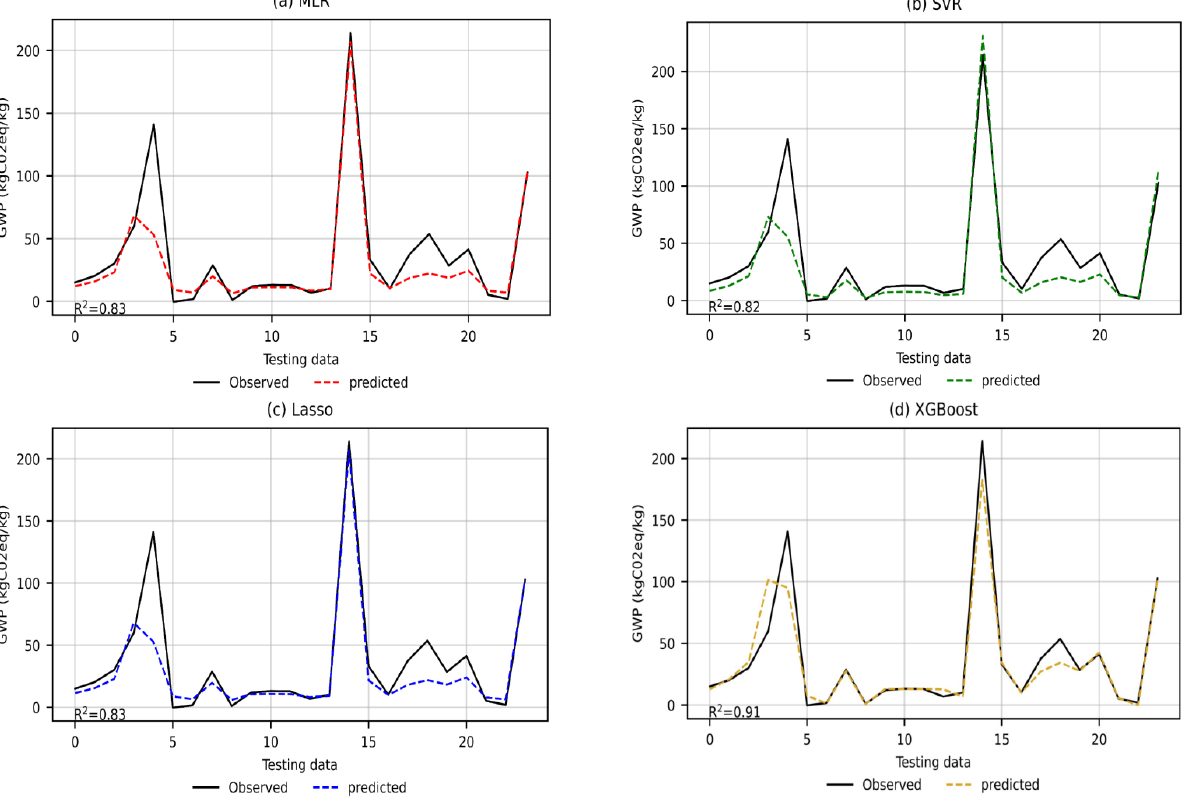
Figure 6. ( a – d ): Holdout charts of observations versus predictions for the models.